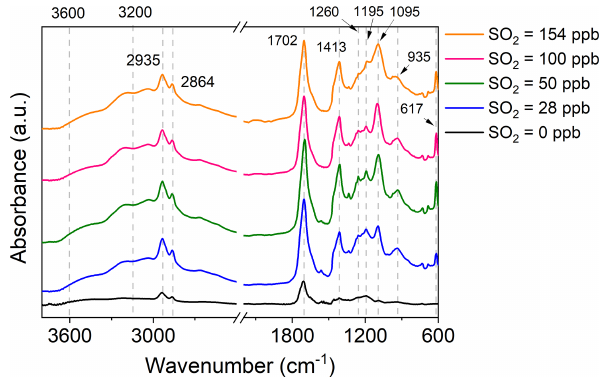
Figure 2. ATR-FTIR spectra of aerosol particles generated from cyclooctene ozonolysis in the presence of different SO 2 concentra- tion.